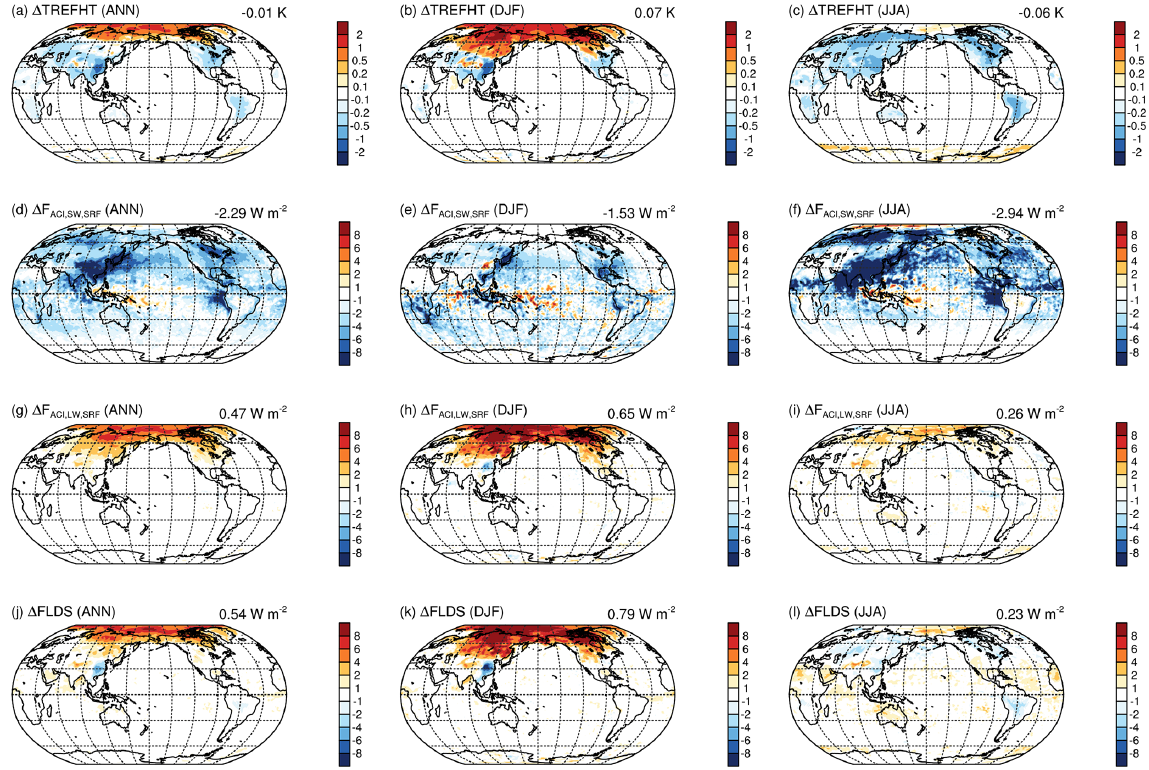
Figure 17. Global annual and seasonal mean changes in near-surface temperature at 2m ( (cid:49) TREFHT, K), decomposed ACI forcing at the surface ( (cid:49)F ACI , SRF , Wm − 2 ), and downward longwave radiation flux ( (cid:49) FLDS, Wm − 2 ) due to the anthropogenic aerosol effects. See Sect. 7 for